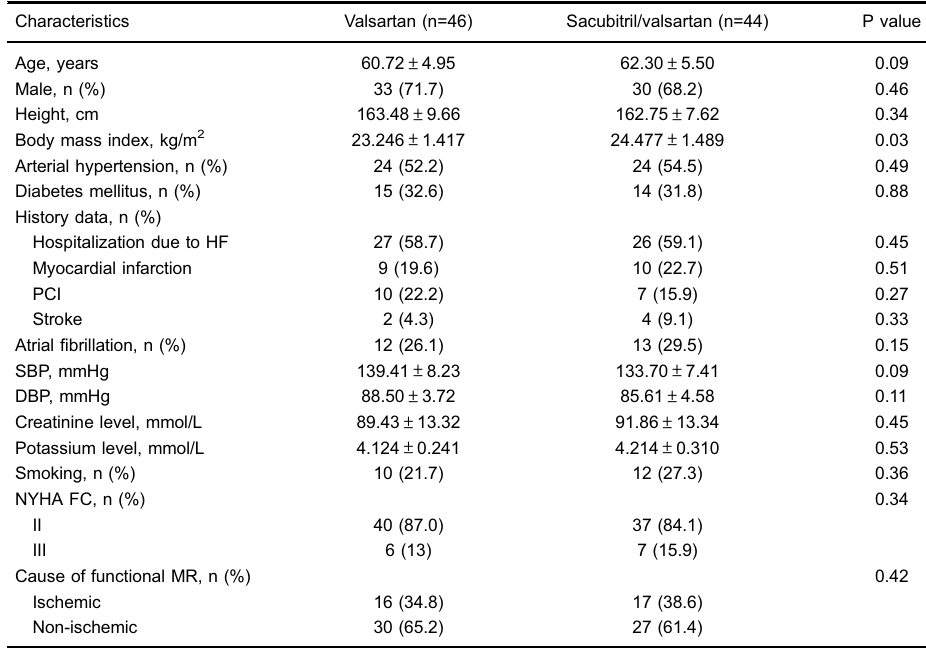
Table 1. Data of patients included in the study according to